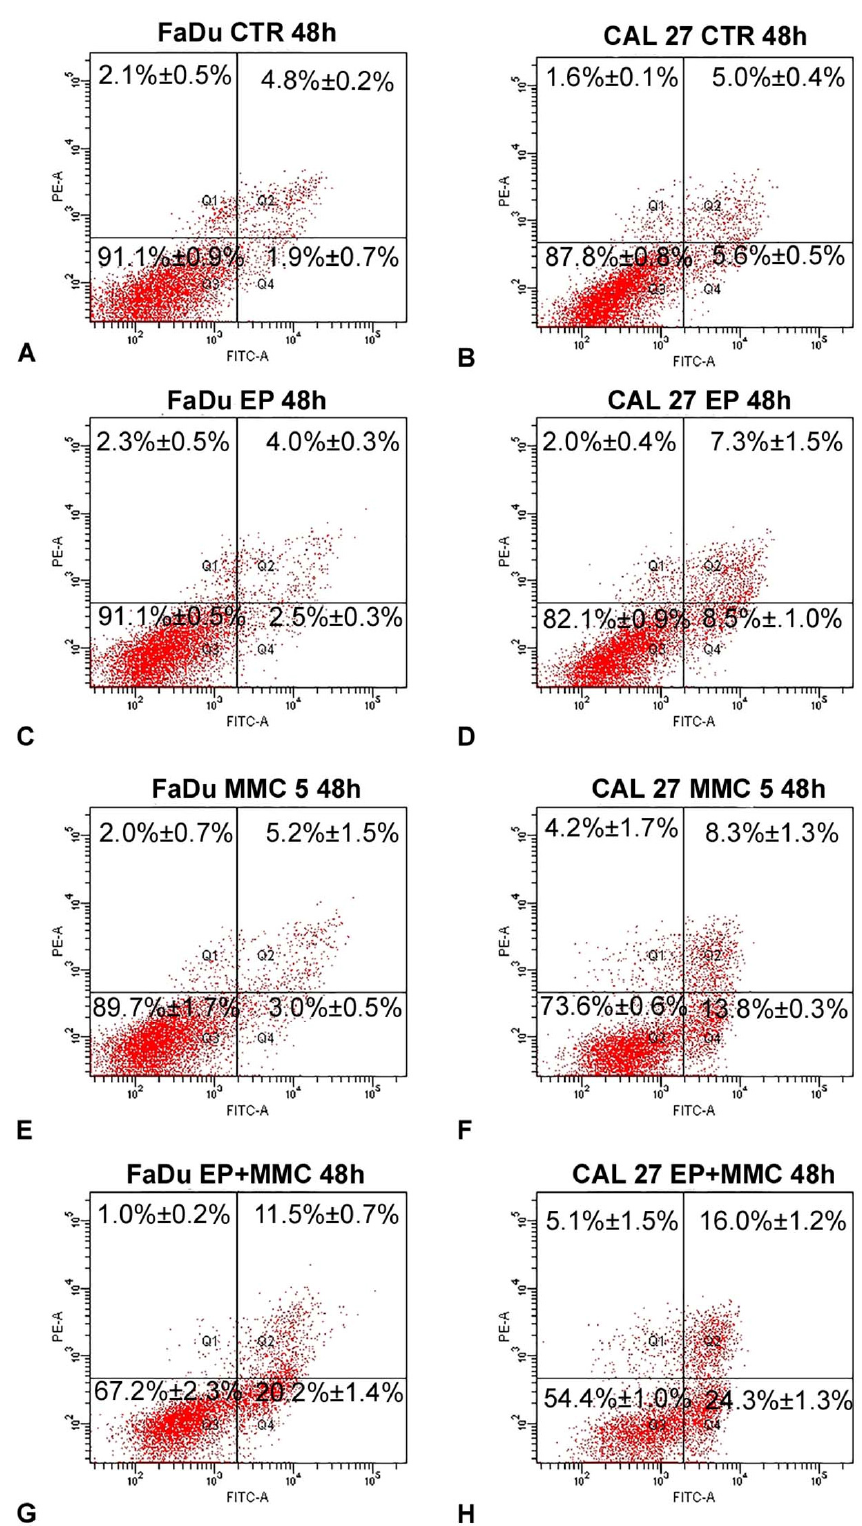
Figure 8. Representative dot plots of apoptosis induction on FaDu and CAL 27 cells after Annexin V/PI dual staining. ( A , B ) Control cells; ( C , D ) treated with EP; ( E , F ) MMC (5 µM for 48 h); ( G , H ) combined treatment (EP+MMC). Dot plots are representative of three independent experiments; values indicate mean±standard deviation.